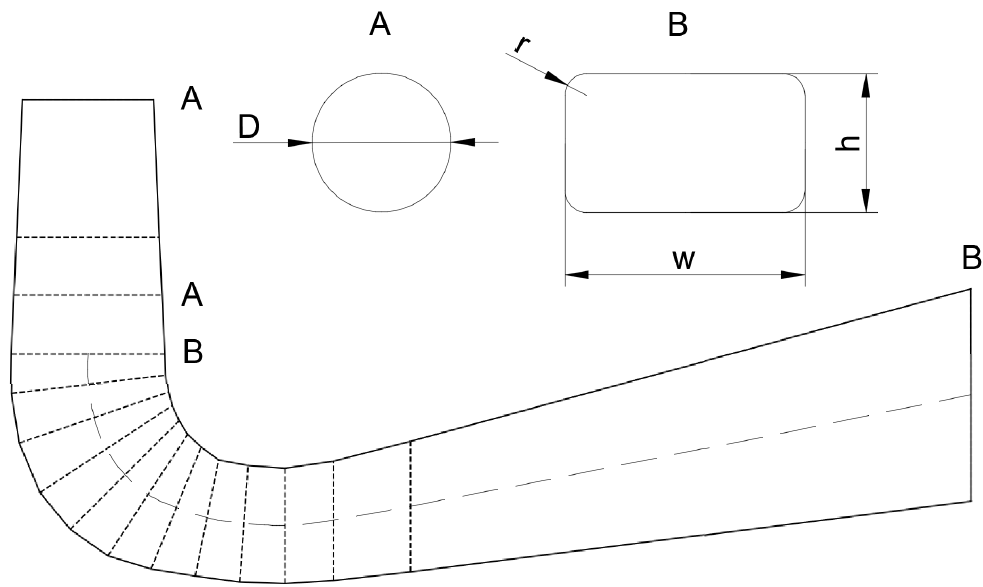
Figure 1. Draft tube used for the optimization with different